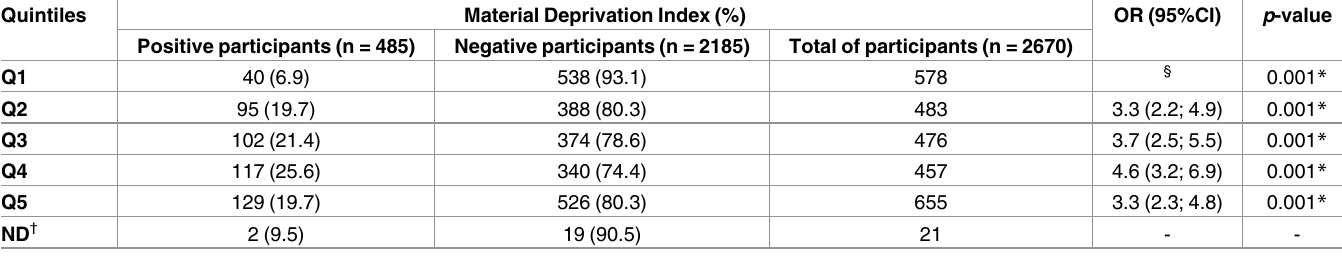
Table 8. Number of positive and negative participants to intestinal parasitesper quintile of deprivation. Quintiles